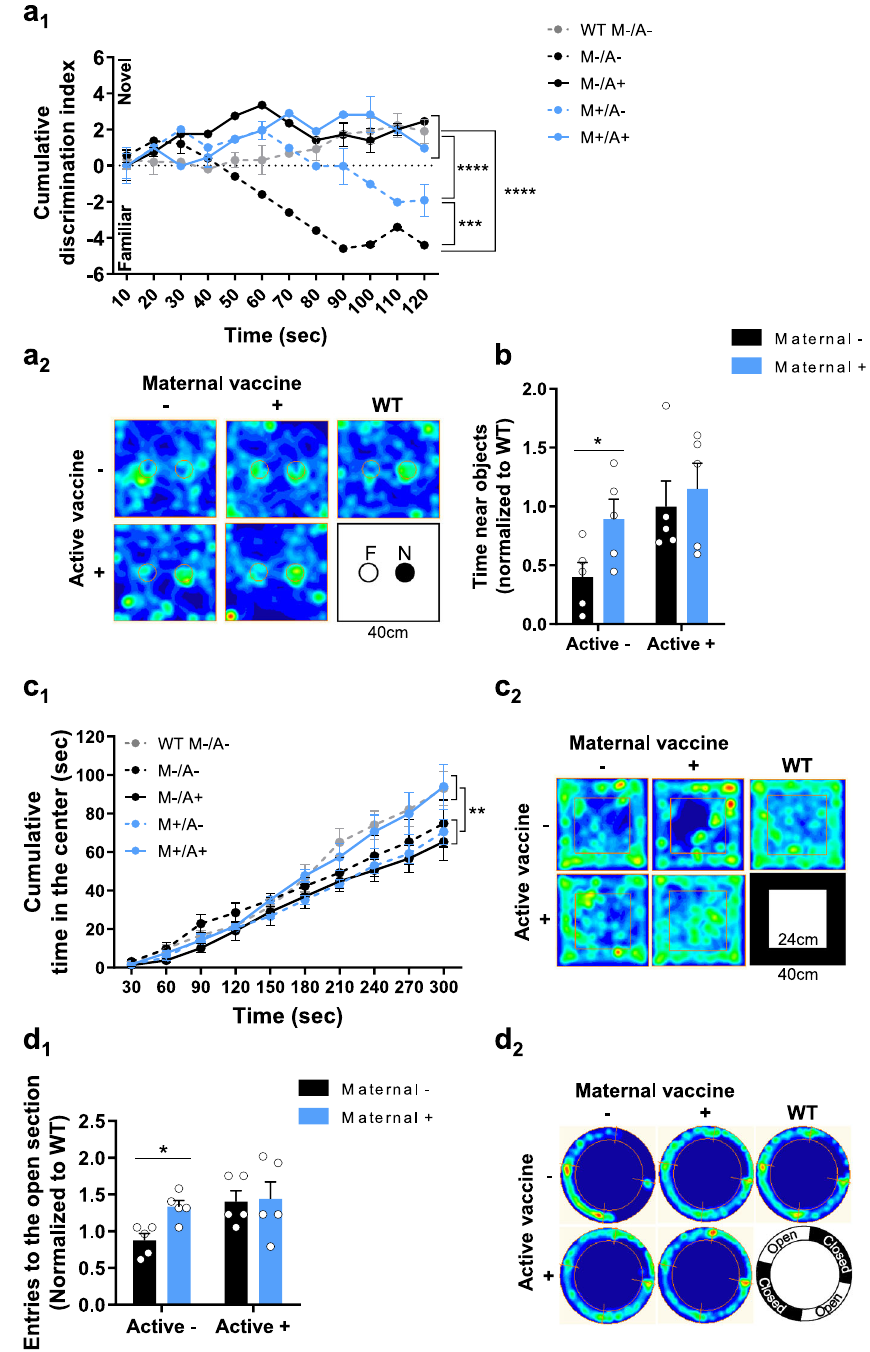
Fig. 3 Combination of maternal and active vaccination rescues short-term memory abilities and normalizes exploratory behavior. A behavioral battery was conducted at 4 m of age ( n = 5 ) to assess the effect of maternal and active vaccinations on cognition. a 1 Short-term memory was assessed using the NOR test. a 2 Occupancy plots of NOR arena — F (familiar object), N (novel object). b Total time near objects in the NOR test. c 1 Exploratory behavior in the OF test. c 2 Occupancy plots of the OF arena. d 1 Anxiety-related behavior in the EZM. d 2 Occupancy plots of the EZM. * P < 0.05, ** P < 0.01, *** P < 0.001, **** P < 0.0001, two-way ANOVA, repeated measures two-way ANOVA, data are presented as mean ±